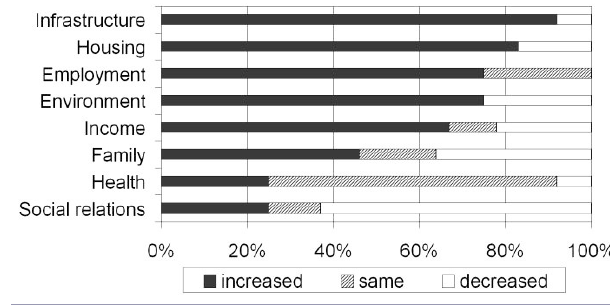
Fig. 6 . Perceived changes in quality of life aspects over the past 50 yrs (percentage of all